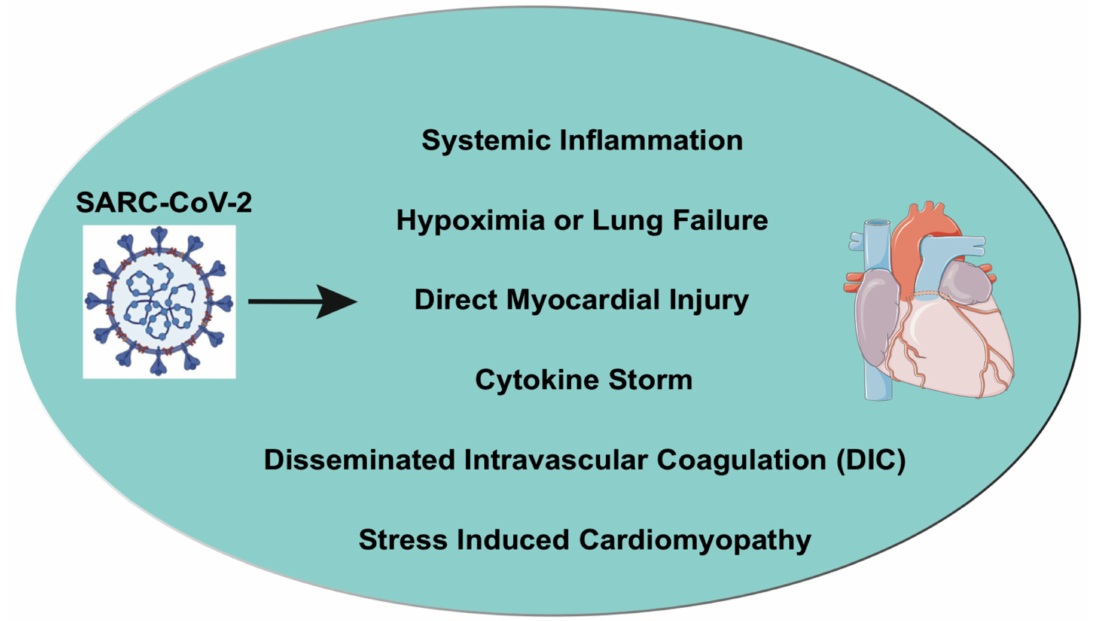
Figure 2. The hypothetical mode of action on heart in COVID-19. COVID-19 can induce cardiovascular complications through di ff erent mechanisms, including direct myocardial infection or injury, cytokine storm, hypoxemia or lung failure, systemic inflammation, DIC, and stress-induced